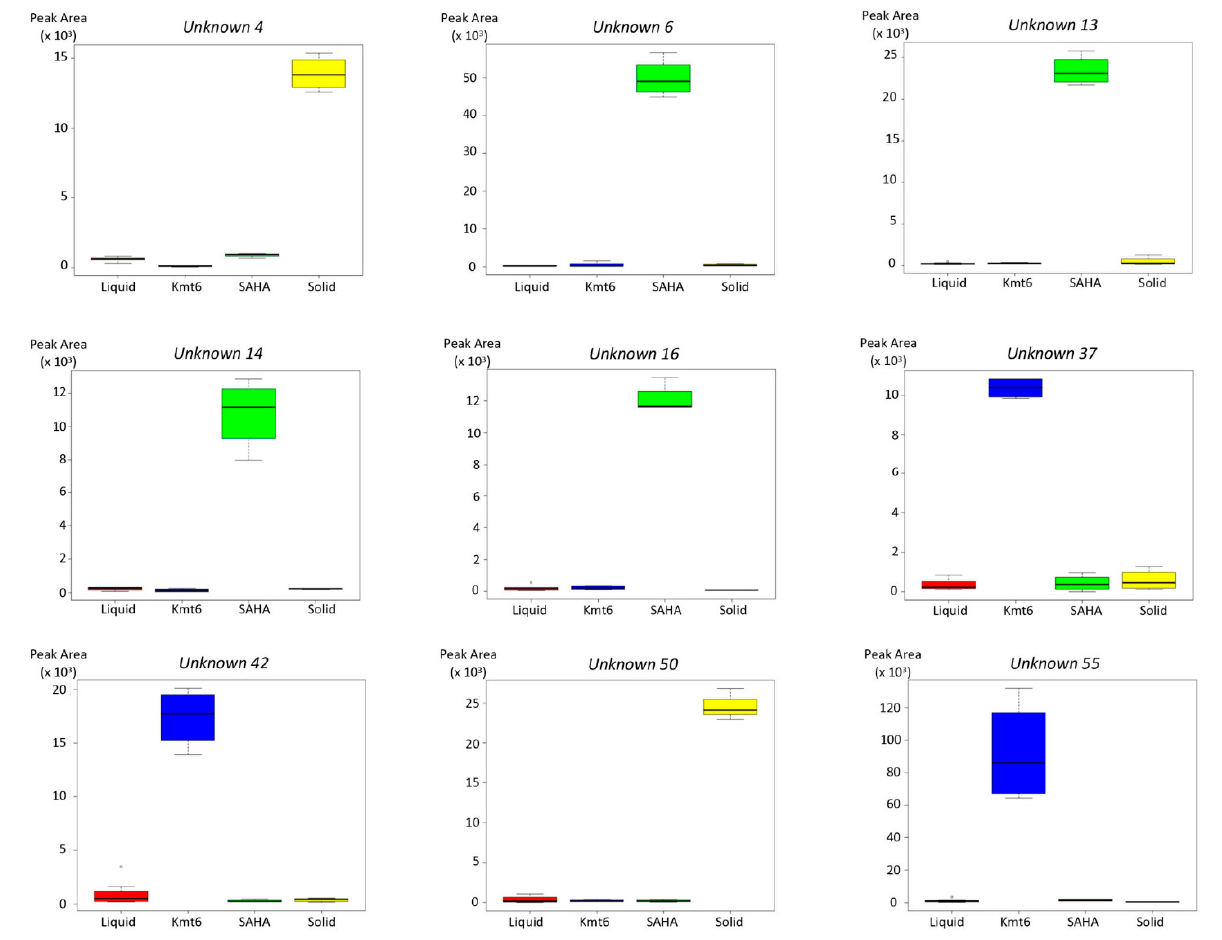
Figure 5. Boxplots representing the respective peak areas on the four different conditions for 9 selected unknown compounds, for which no match with compounds already reported from ascomycetes in DNP was obtained (from Table S1): Unknown 4 ( t R = 4.67 min, m / z = 203.0391), unknown 6 ( t R = 5.36 min, m / z = 243.1143), unknown 13 ( t R = 6.61 min, m / z = 263.1763), unknown 14 ( t R = 6.64 min, m / z = 424.1998), unknown 16 ( t R = 6.74 min, m / z = 222.1537), unknown 37 ( t R = 8.68 min, m / z = 469.164), unknown 42 ( t R = 10.17 min, m / z = 165.9889), unknown 50 ( t R = 11.24 min, m / z = 563.3802), and unknown 55 ( t R = 14.35 min, m / z = 428.3066). Peak areas were obtained by integration of the corresponding peak on extracted ion chromatograms from UPLC data. “Liquid”: M2 liquid medium inoculated with WT; “Solid”: M2 solid medium inoculated with WT; “SAHA”: M2 liquid medium supplemented with 100 μ M SAHA and inoculated with WT; “Kmt6”: M2 liquid medium inoculated with the Kmt6 mutant strain. All the experiments were performed in quadruplicates, except for the condition “Liquid” for which 8 replicates were performed.